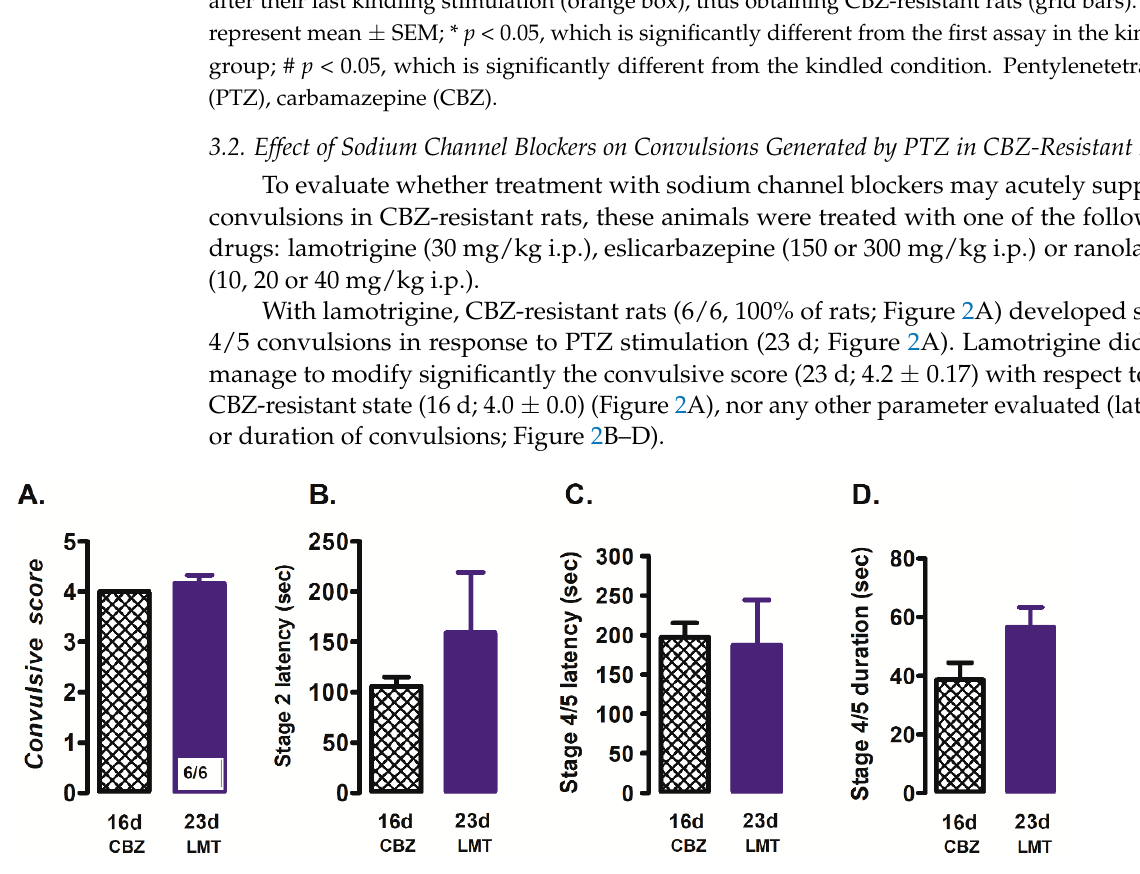
Figure 2. Effects of lamotrigine (23 d; LMT, 30 mg/kg i.p.) on convulsive score ( A ), stage 2 latency ( B ), latency ( C ) and duration ( D ) of the stage 4/5 convulsions with respect to the CBZ-resistant state (16 d). Data represent mean ± SEM. Carbamazepine (CBZ).